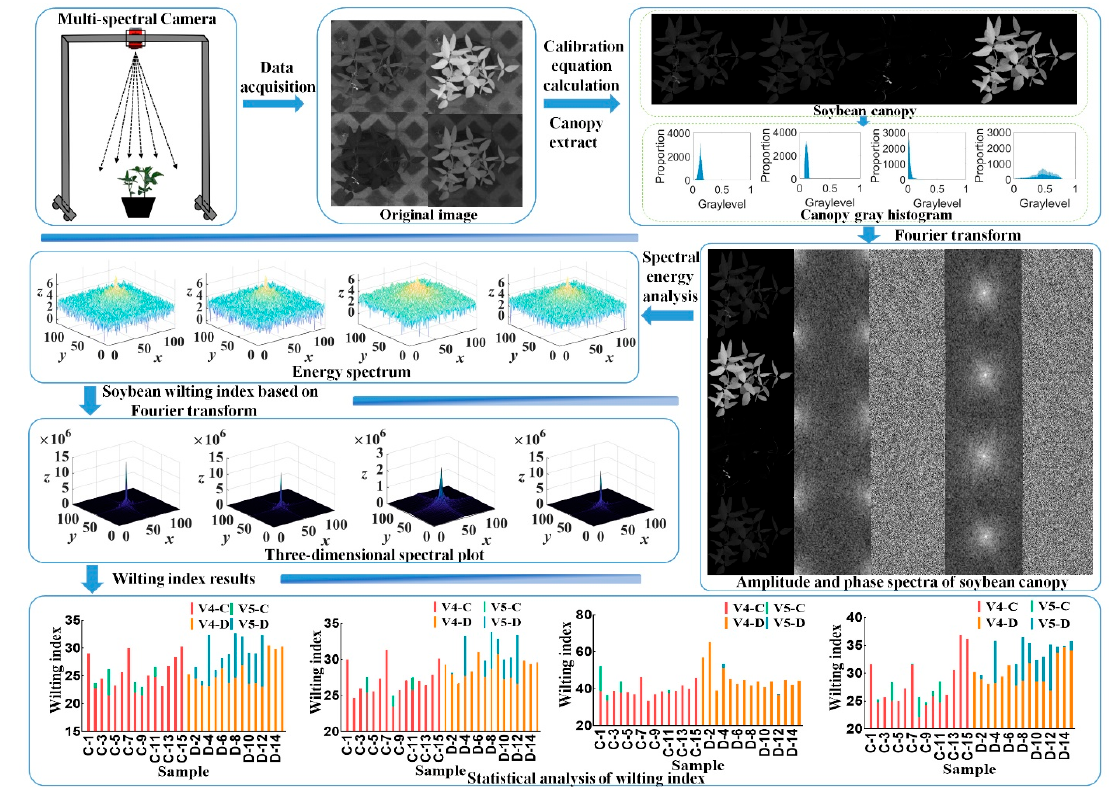
Figure 3. Overall framework of the calculation method of the wilting index for the soybean canopy.